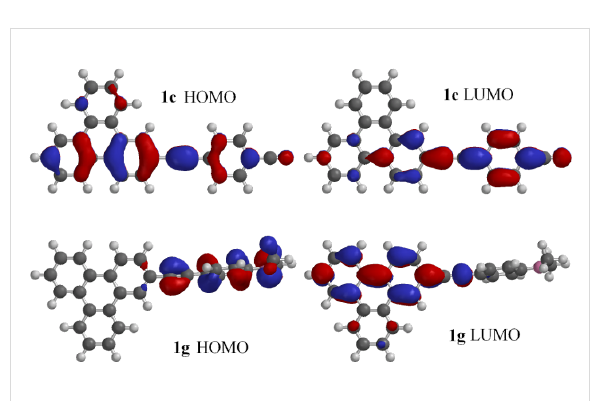
Figure 7: HOMO and LUMO surfaces of 1c and 1g according to DFT